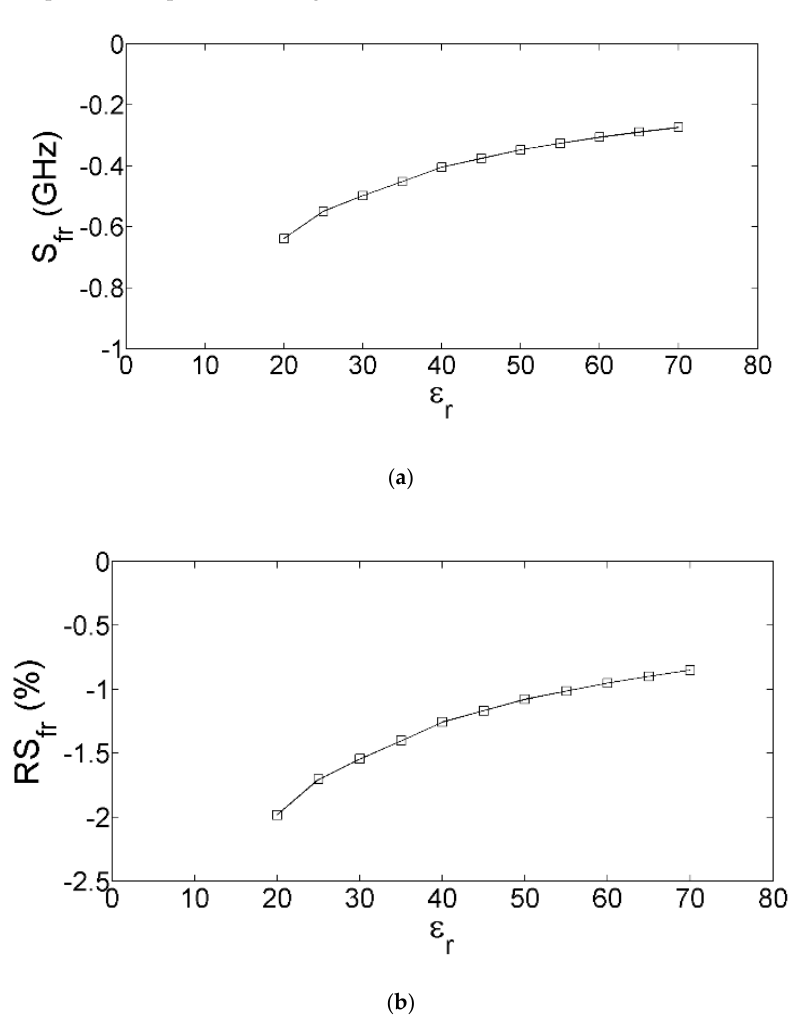
Figure 5. Behavior of the ( a ) absolute and ( b ) relative sensitivity of f r to variations in ε r for the lossless MUTs placed on top of the sensing area of the IDC sensor. When ε r is 20, S fr and RS fr reach their maximum magnitude of 0.638 GHz/ Δ 1 and 1.98%, respectively.